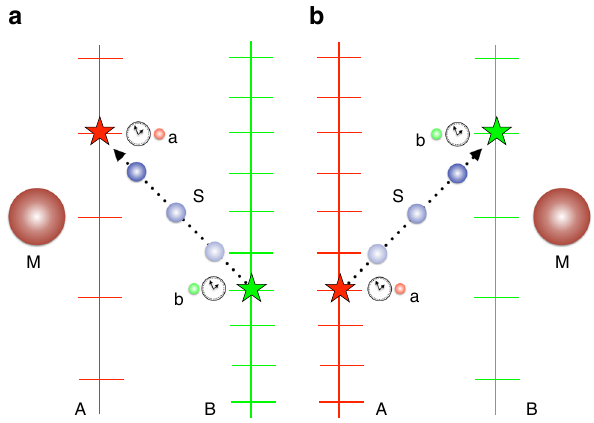
Fig. 4 Experimental set up of the gravitational switch. The mass M can be either close to A ( a ) or to B ( b ). A (B) applies an operation on the system S by means of an ancilla a (b). A ’ s operation is in the causal future (past) of B ’ s operation when the mass is on the left (right). This fact is depicted by the system traveling from B to A ( a ) and from A to B ( b ). In the quantum switch experiment, the mass is put in a superposition between being close to A and close to B, leading to a superposition of causal